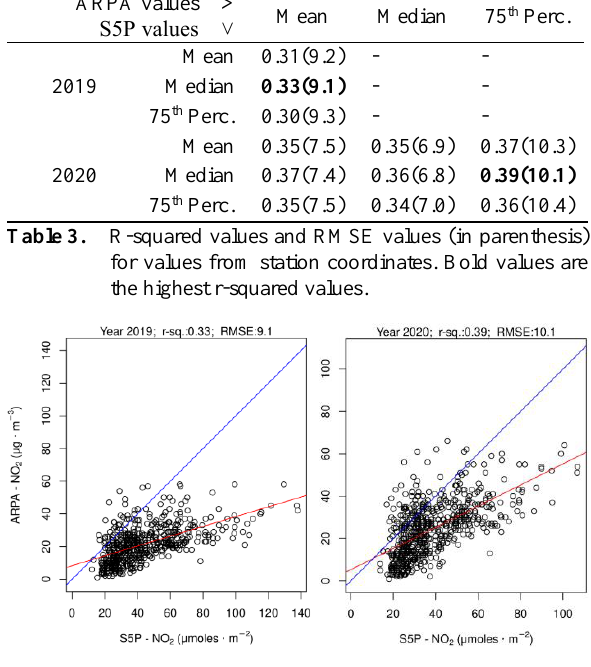
Figure 9. Highest r-squared values ( Table 3) for 2019 (left) and 2020 (right) from ground measures at station coordinates.